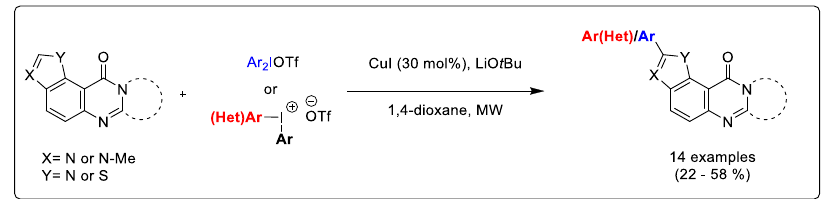
Figure 37. Cu-catalyzed C-H arylation process using diaryliodonium salts.